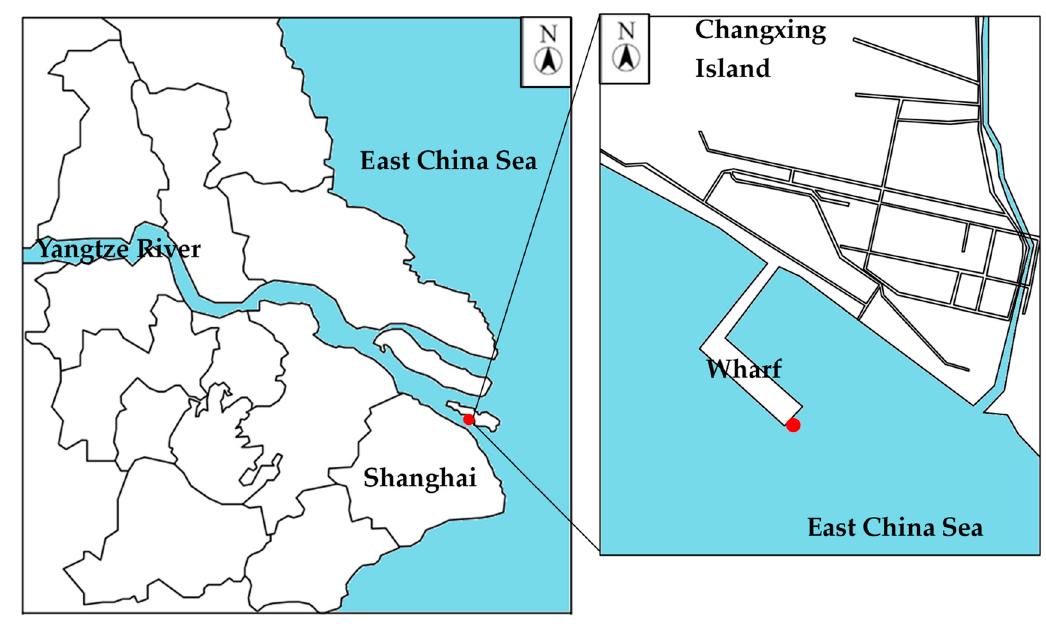
Figure 1. Schematic diagram of the test site.